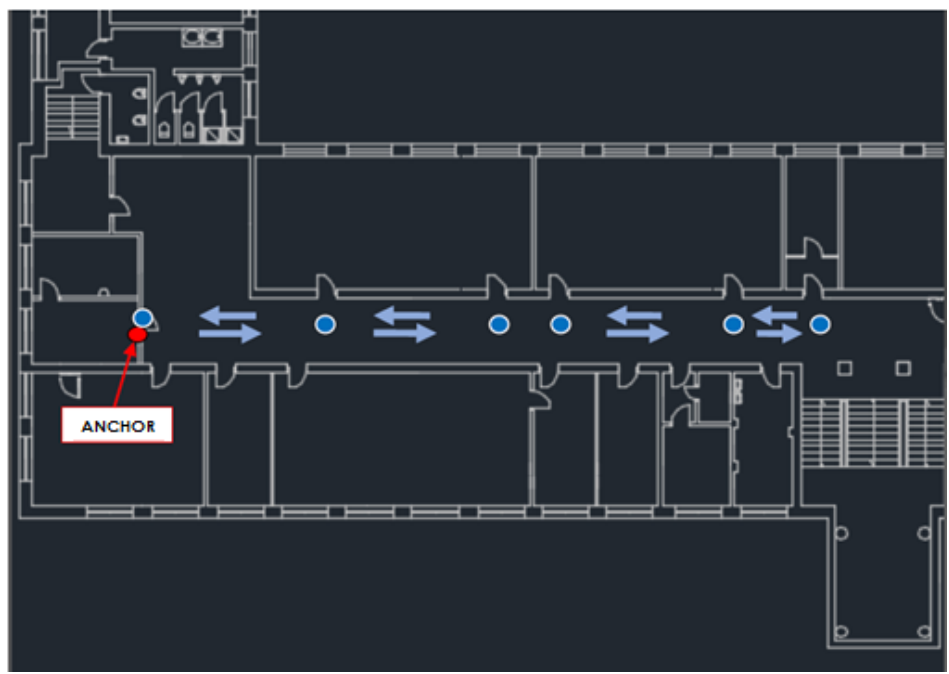
Figure 8. Marked stop points (known coordinates) for the path in Test